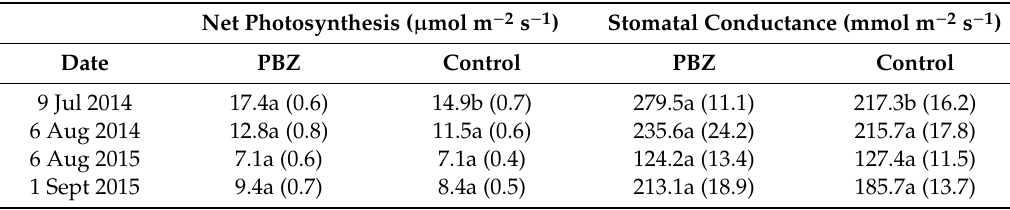
Note: means within row for a given variable followed by the same letter are not di ff erent at p = 0.05 (n =